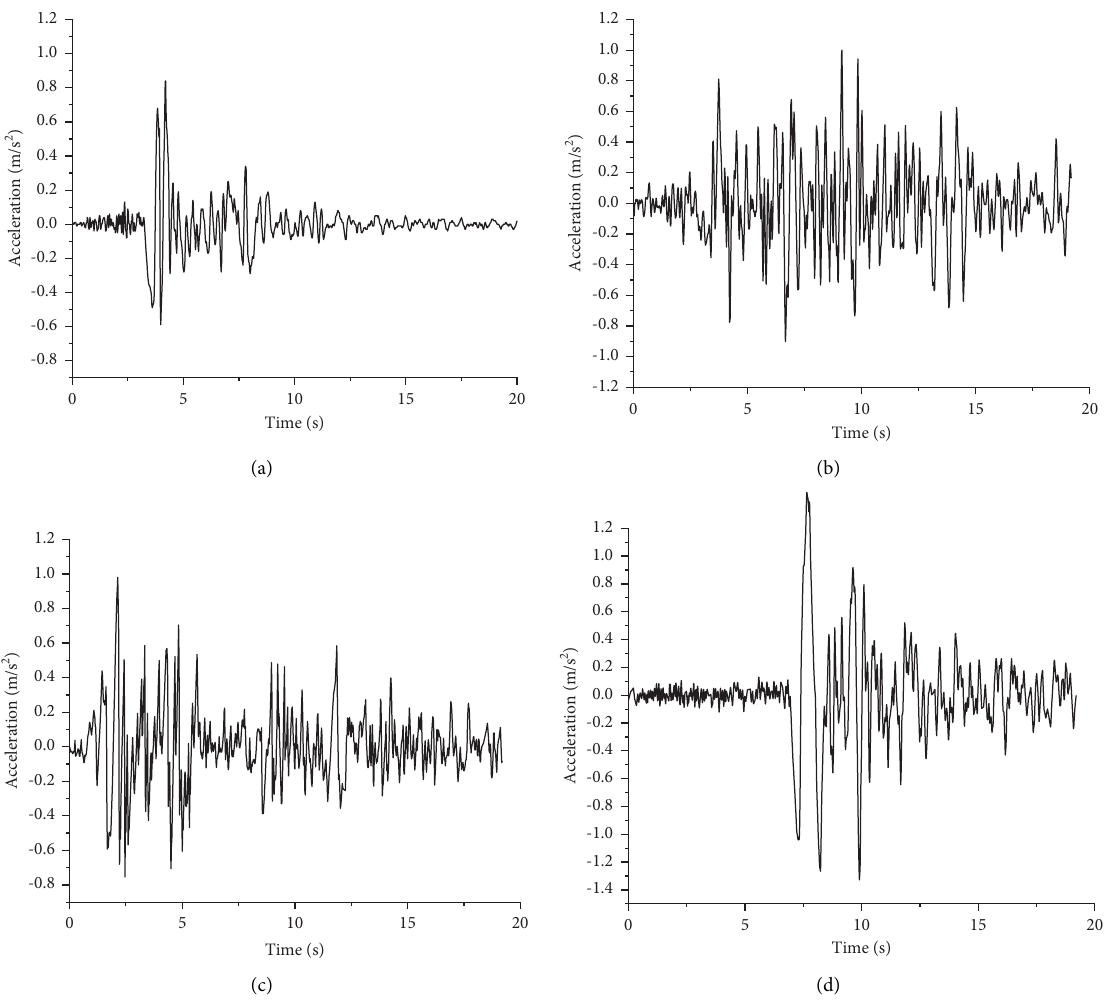
Figure 16: Time-history curves of four seismic waves. (a) Northridge wave time history curve. (b) Taft wave time history curve. (c) EL Centro wave time history curve. (d) Tianjin wave time history curve.